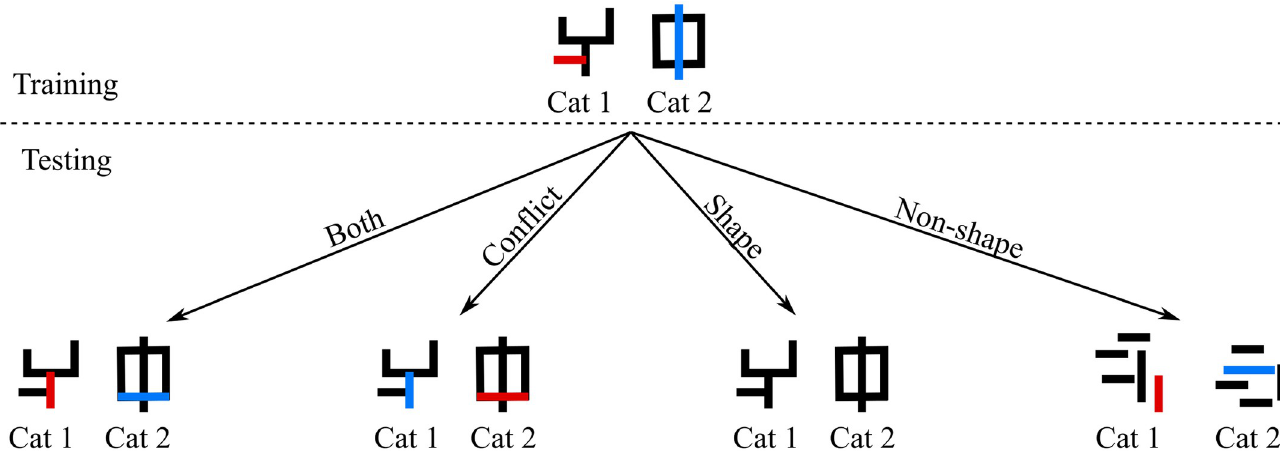
Fig 2. An illustration of the four types of test conditions. Each category has two diagnostic features: here, the overall shape and the colour of one of the segments. In the training images, features are mapped to categories using the following mapping: {(Shape A, Red) ! Category 1; (Shape B, Blue) ! Category 2}, where Shape A and Shape B are the shapes on the left and right, respectively. In the Both test condition, both types of features (shape and colour) have the same mapping as training. In the Conflict condition the mapping of the non-shape feature is swapped—i.e., the new mapping is {(Shape A, Blue) ! Category 1; (Shape B, Red) ! Category 2}. In the Shape condition, images have only one diagnostic feature—the overall shape—which has the same mapping as training: {Shape A ! Category 1; Shape B ! Category 2}. In the Non-shape condition, images have no coherent shape, but contain the same diagnostic colours as the training images: {Red ! Category 1; Blue ! Category